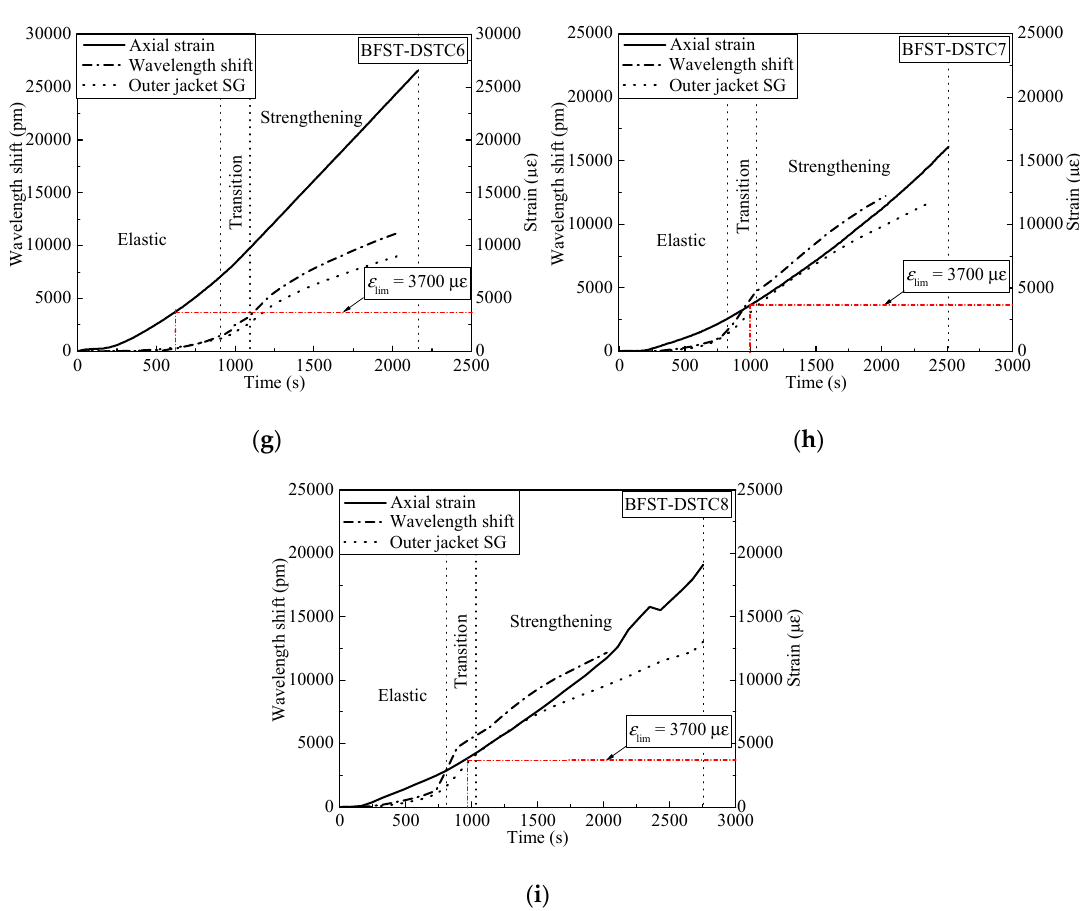
Figure 8. Axial strain monitoring based on outer tube wavelength shift (WS) for specimens: ( a ) hybrid DSTC1; ( b ) BFST-DSTC1; ( c ) BFST-DSTC2; ( d ) BFST-DSTC3; ( e ) BFST-DSTC4; ( f ) BFST-DSTC5;